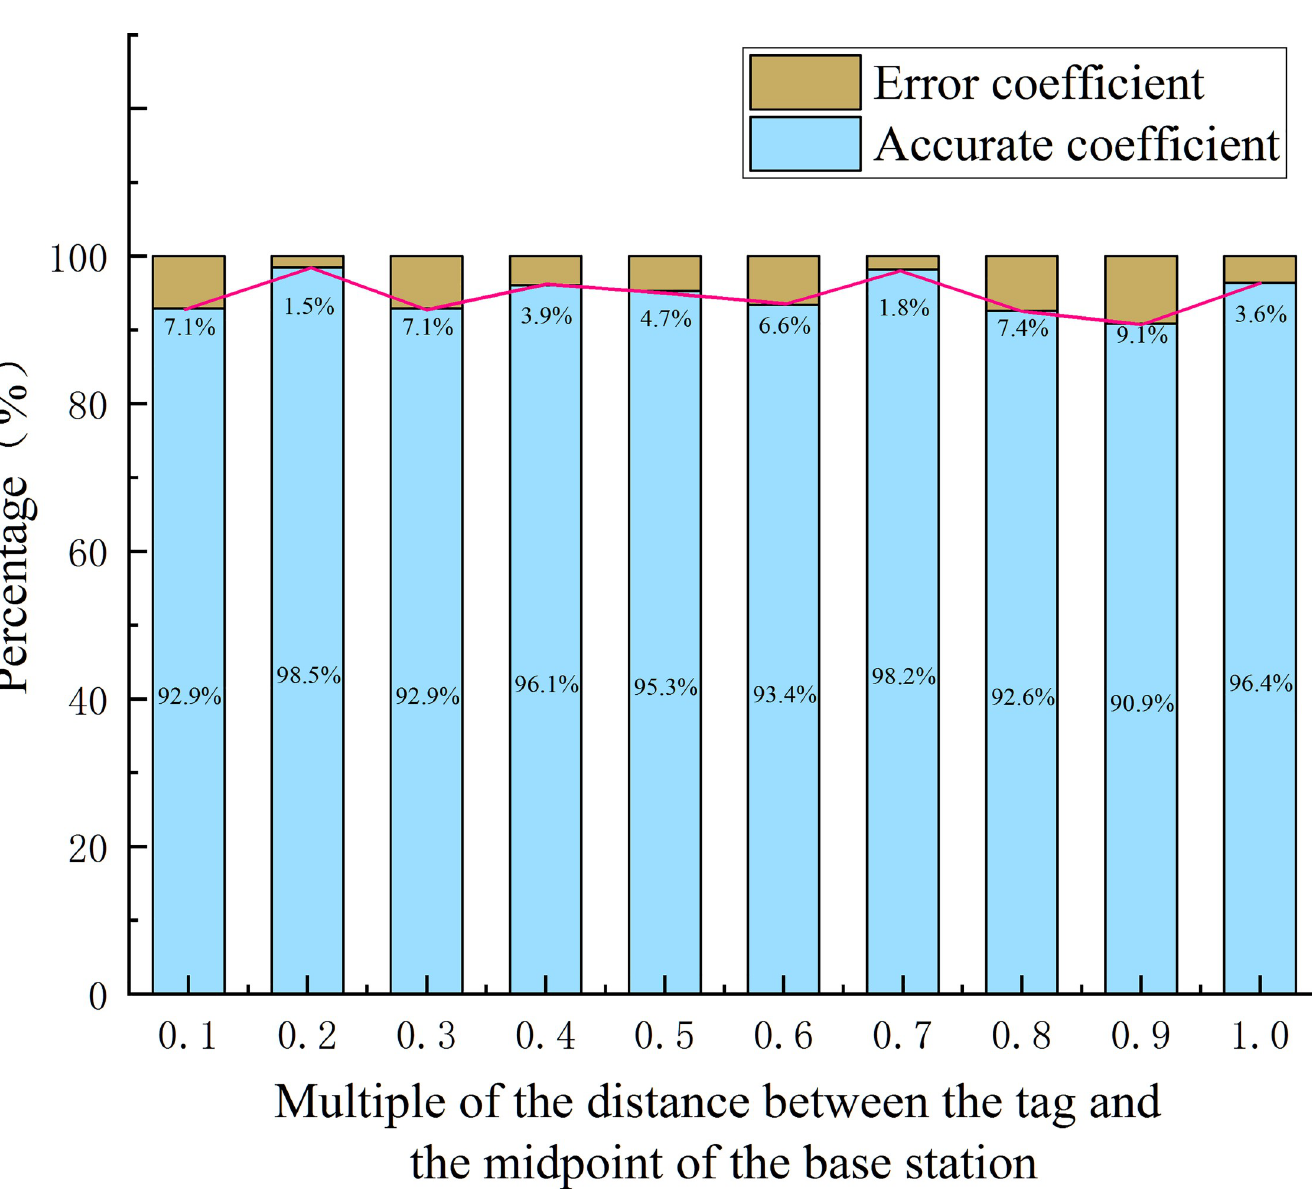
Table 1 shows that the system delay ranges from 0.43 s (for a separation of base stations of 70 m) to 1.72 s (for a separation of base stations of 20 m) as the separation of base stations ranges 20–80 m. This is because the required flight time is short and the system delay time improves when the base stations are close. The flight time of the wireless pulse increases with the distance between the base stations, which worsens the system delay. However, the flight distance of the wireless pulse increases as the distance between the base stations increases, causing the system delay time to increase again. Fig 15 reveals that the positioning delay time is within 0.5 s when the distance between base stations is 50–70 m, which meets the require- ment of a small delay [29]. According to reference 29, the signal delay is less than half of the signal duration, which is a low delay. In this paper, the duration of the signal can be regarded